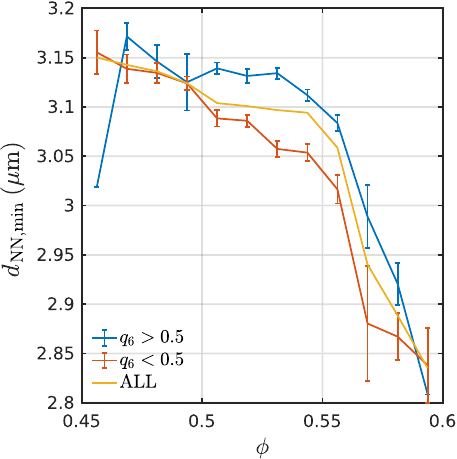
FIG. 8. Distance to the closest nearest neighbor d as a function of volume fraction ϕ for particles with different crystallinity, as